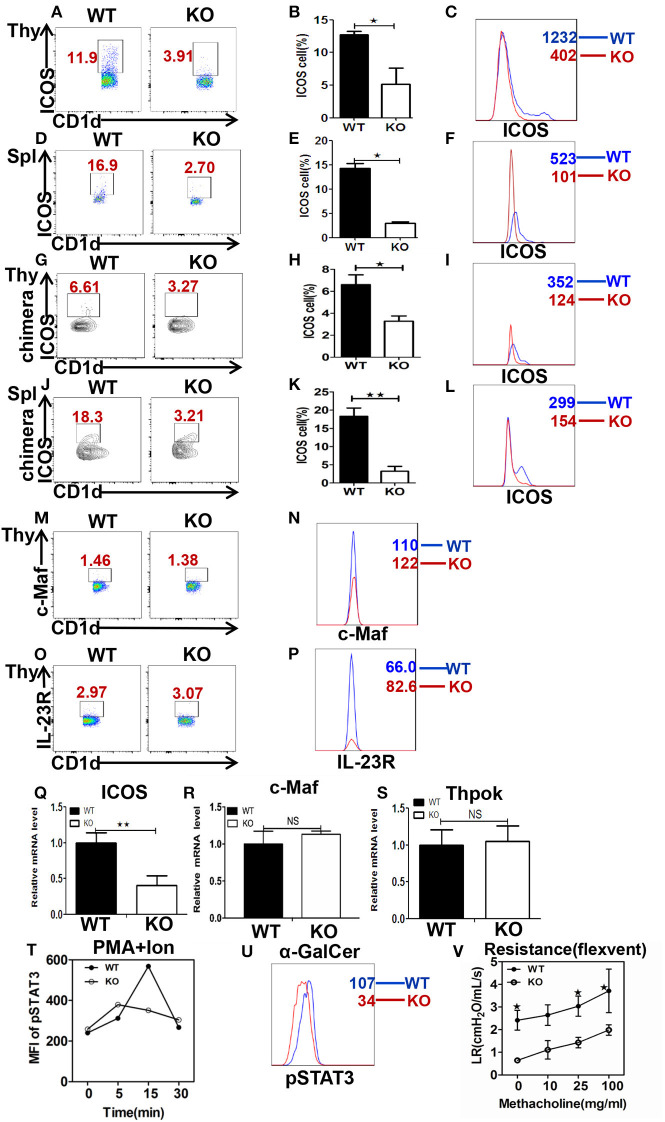
Akt2 regulates the NKT17 differentiation by promoting the expression of ICOS. (A–F) The percentages of ICOS of WT and Akt2 KO cells in thymus (n = 3 mice per group) and spleen (n = 3 mice per group) is shown. (C,F) Overlaid histograms show expression of ICOS in the thymus and spleen. (G–L) The percentages of ICOS of CD45.2+ cells in thymus and spleen of WT chimera mice (n = 4) and Akt2 KO chimera mice (n = 3) is shown. (I,L) Overlaid histograms show expression of ICOS in the thymus and spleen of chimeras. (M,N) The Flow cytometry of c-Maf and expression of c-Maf in the thymus. (O,P) Flow cytometry of IL-23R and expression of IL-23R in the thymus. (Q–S) mRNA levels of indicated molecules in WT and Akt2 KO iNKT cells. Expression of indicated mRNA from MACS- and FACS- sorted WT and Akt2 KO iNKT cells from freshly isolated thymocytes was quantified by real-time qPCR from three independent experiments. *p < 0.05; **p < 0.01, Student's t-test. (T) Flow cytometry analysis of the pSTAT3 for MFI in thymocytes from WT (n = 3) and Akt2 KO mice (n = 3). (U) Overlaid histograms show expression of pSTAT3 after α-GalCer stimulated 72 h. (V) Airway response to methacholine of WT (n = 3) and Akt2 KO mice (n = 3). LR, lung resistance from two independent experiments. *p < 0.05, Student's t-test.